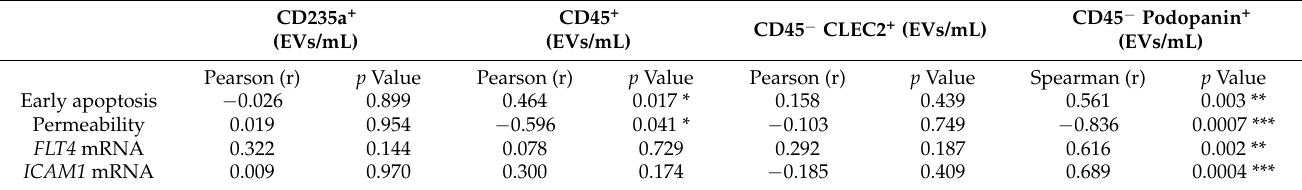
Table 2. Correlation between extracellular vesicles and lymphatic endothelial cell